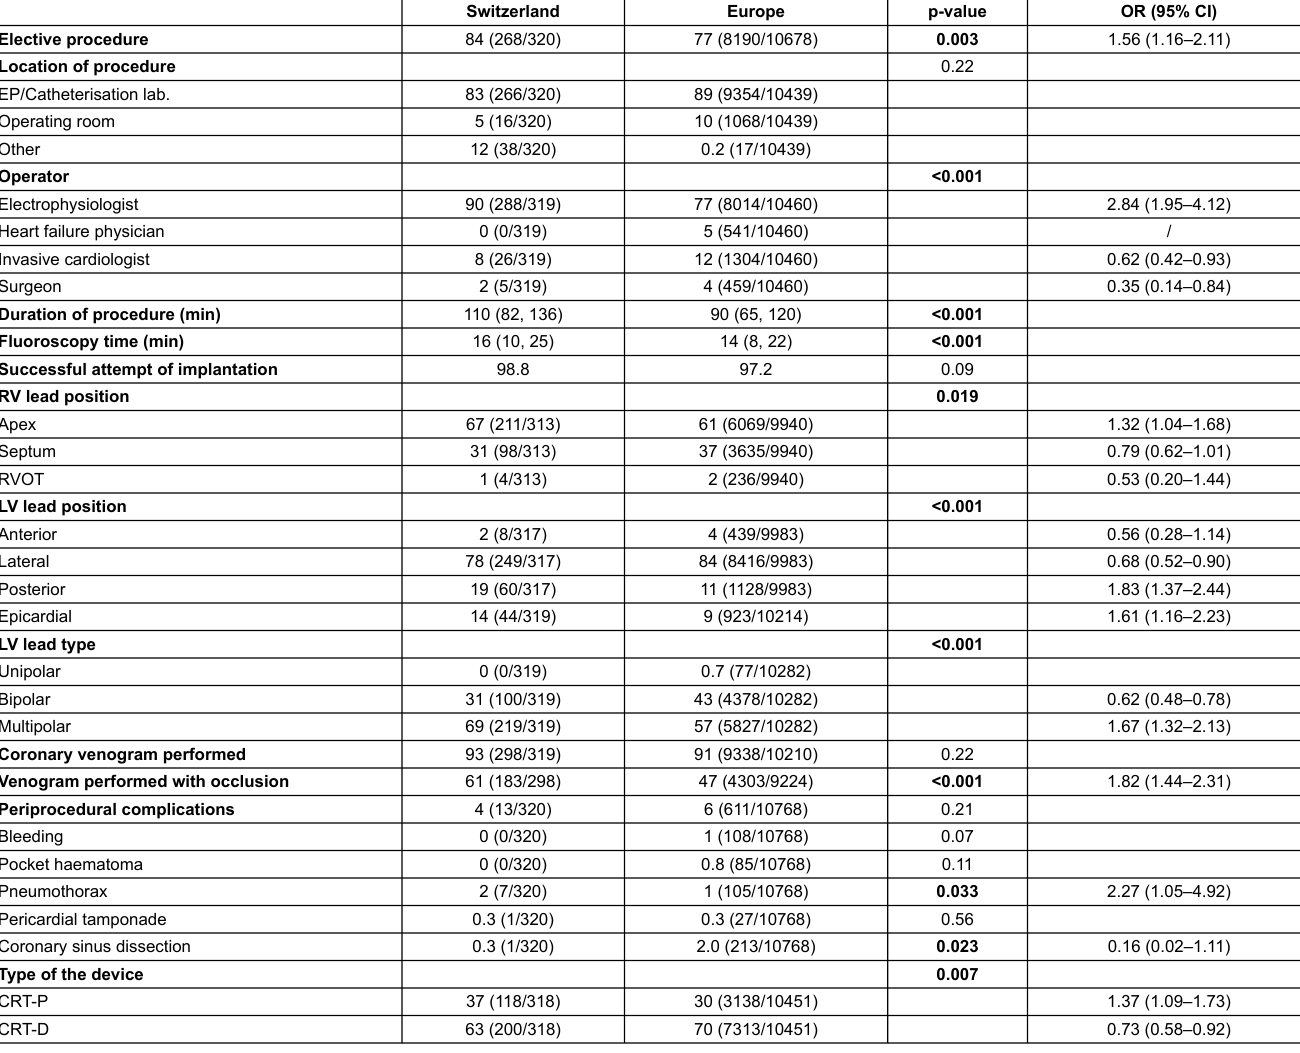
Table 3: Procedural data of Swiss cardiac resynchronisation therapy (CRT) population and comparison with the European